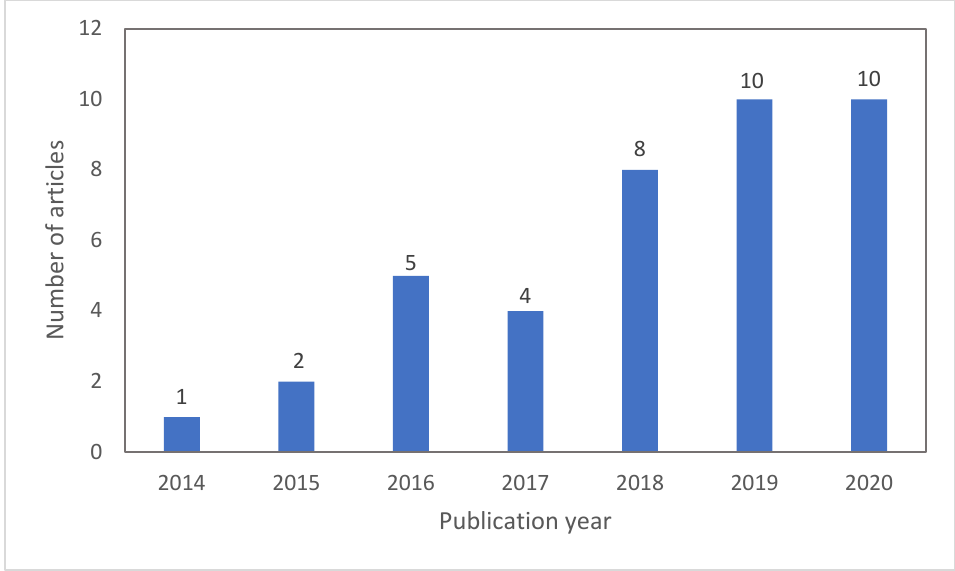
Figure 1. Evolution of scientific articles published in JCR-indexed journals on bio-based aerogels for wound treatment. Search criteria was “aerogel” AND “wound” in Web-of-Science database (source: WoS; search date: 2 February 2021), followed by the following refinements after hits revision: articles not intended for wound treatment or using porous materials that do not present mesoporosity were excluded, and addition of articles that were not in the database but were used for the preparation of this review article.